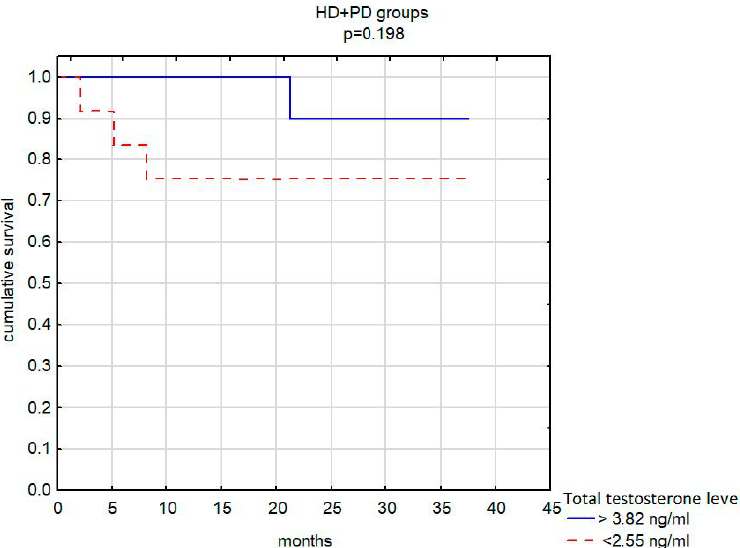
Figure 2. The probability of survival in the group of men on dialysis depending on the concentration of total testosterone in the blood serum. Table 5. ROC analysis of androgen serum concentration in the prognosis prediction in men undergoing hemodialysis.